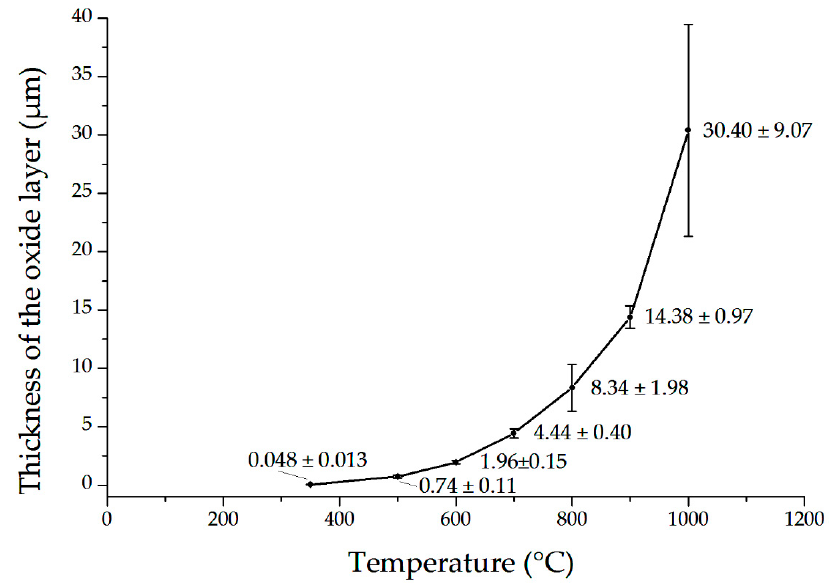
Figure 4. The thickness of the oxide layer formed at a different temperature for 30 min. The means standard deviations based on five independent measurements are and standard deviations based on five independent measurements are shown.